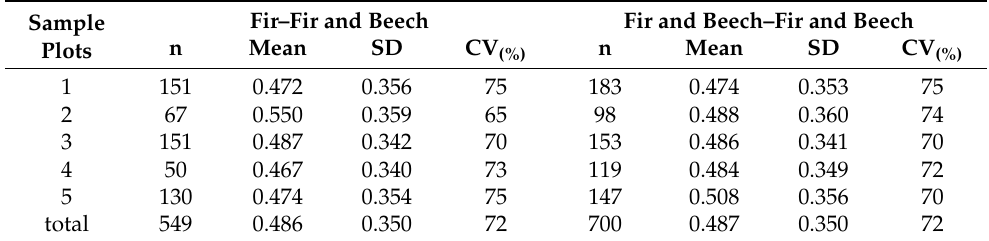
Table 5. The Weber height competition index.